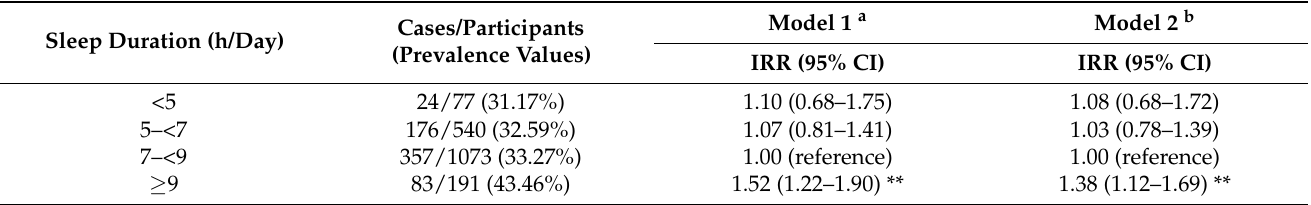
Table 2. Weighted IRRs and 95% CIs of low grip strength according to sleep duration, NHANES